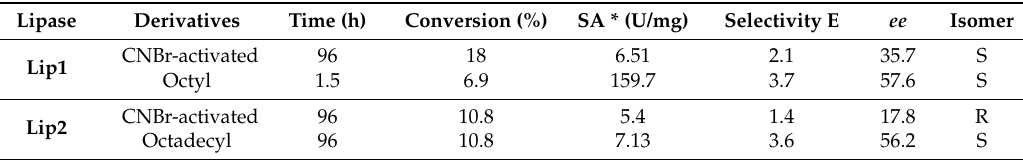
Table 9. HPBE hydrolysis by Lip1 and